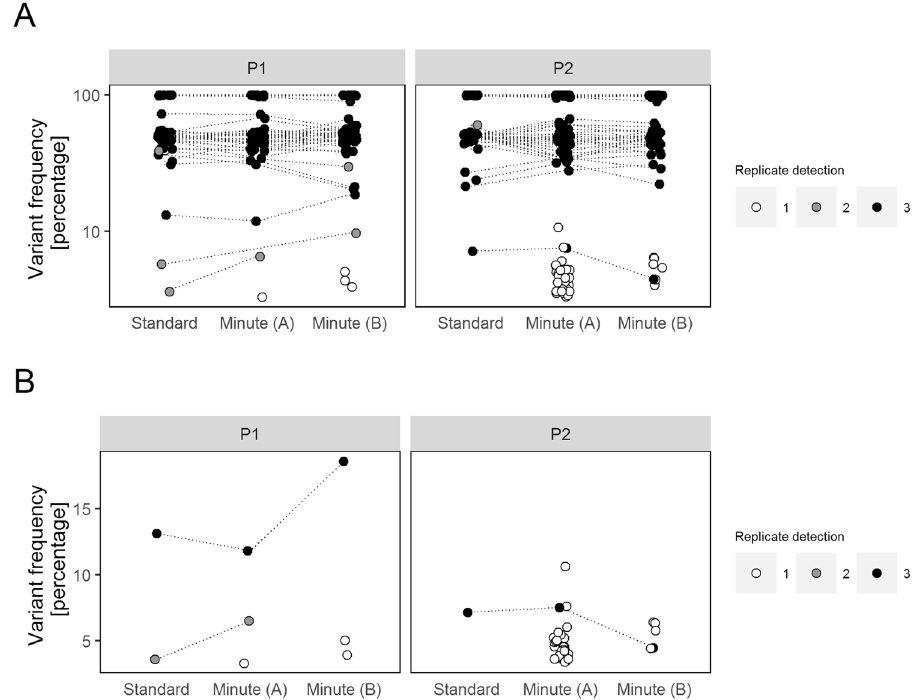
Figure 3. Detection of (somatic) variants in standard and minute primary tumor replicate samples. ( A ) The variant frequency in percentages of variants detected in a single replicate (1, white), in two out of three replicates (2, grey) or in all three replicates (3, black) of the two analyzed patients. Recurrent somatic variants at unique genomic positions are connected by lines to visualize variant frequency between replicates. ( B ) The variant frequency in percentages of somatic variants detected in a single replicate (1, white), in two out of three replicates (2, grey) or in all three replicates (3, black) of the two analyzed patients. Recurrent somatic variants at unique genomic positions are connected by lines to visualize variant frequency between